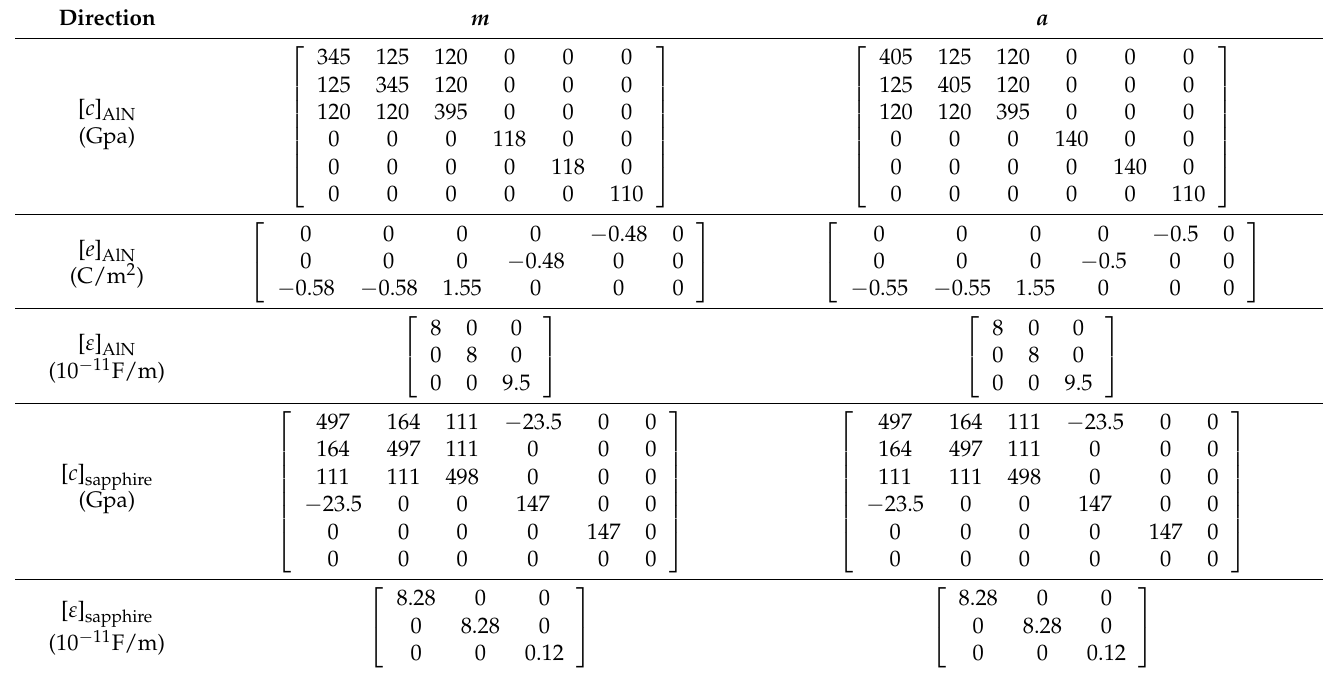
Table 2. Physical constants of AlN and sapphire of m - and a -directions (T = 25 ◦ C).